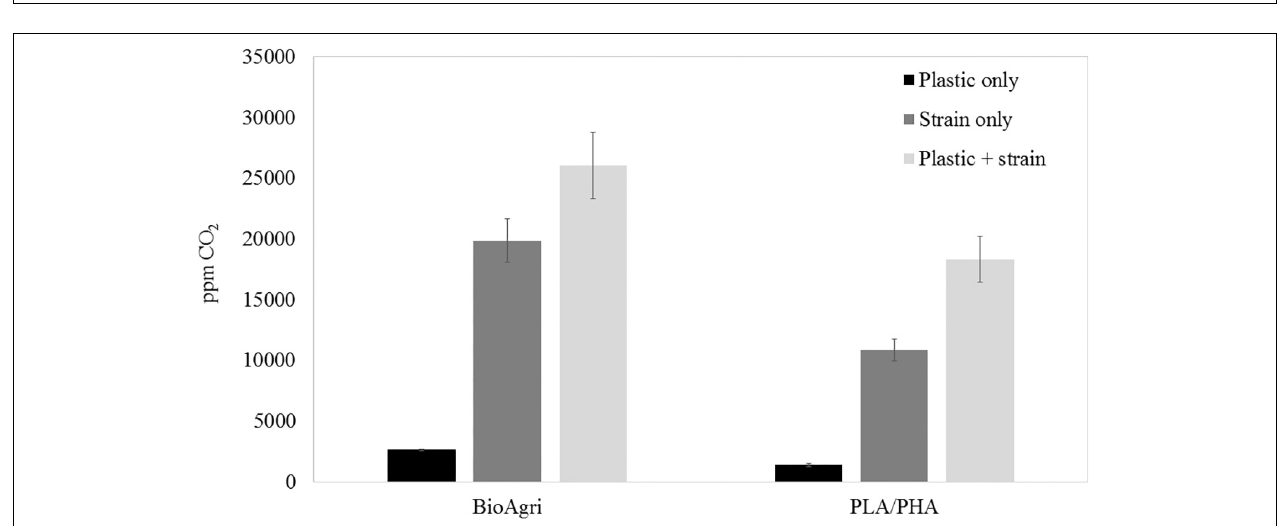
FIGURE 1 | High levels of L-lactate release detected from PLA films exposed to Proteinase K. (A) 10 mg/mL Poly-lactic Acid (PLA) films were incubated at 30 ◦ C for 24 h with serial dilutions of Proteinase K ( n = 3). Supernatant samples were collected and added to a colorimetric L-lactate detection kit. MSM + G represents minimal salt media (MSM) with 55 mM glucose supplementation. (B) PLA films were incubated with 1.6 total units of Proteinase K with supernatant samples being collected at successive time points.